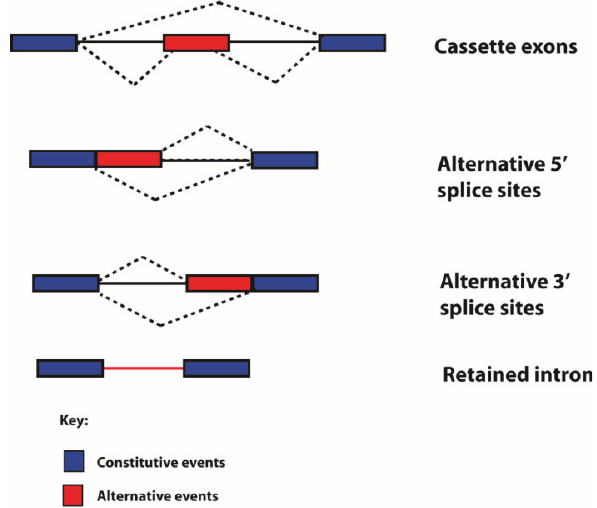
Figure 6. Types of alternative splicing events detected in the human transcriptome. Exons are shown as boxes, introns as lines, and splicing patterns as broken lines. mRNAs can be made from individual genes can using multiple alternative events, including different types of splicing, to build up complex patterns of alternative spliced